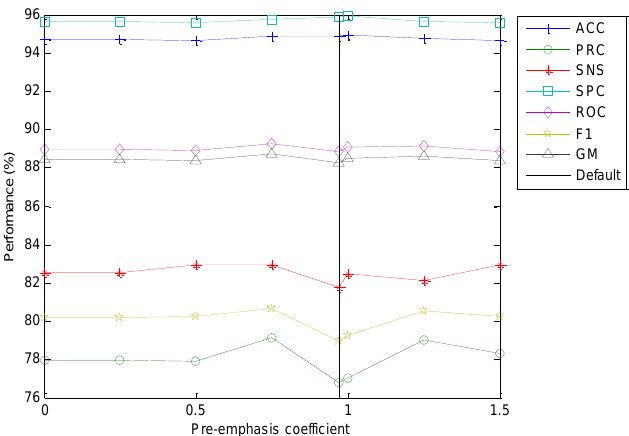
Figure 21. Classification performance metrics of the best classifier vs. the value of the pre-emphasis coefficient.